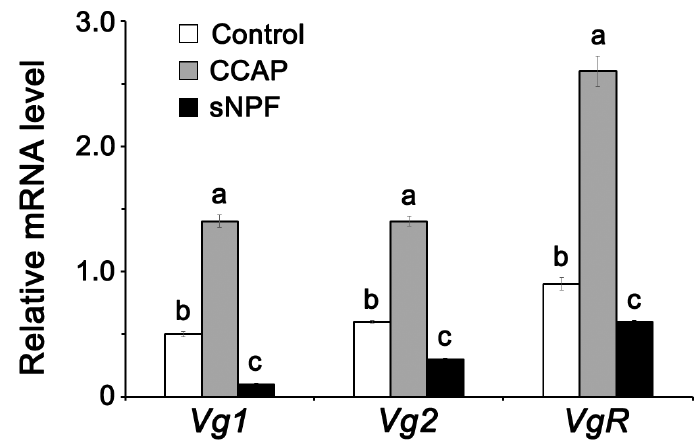
Figure 5. Vg1 , Vg2, and VgR expression in the fat body of normally fed adult females of P. americana 4 days post-injection with CCAP and sNPF. Data are presented as mean ± SEM. Means followed by different letters are significantly different ( p < 0.05), using Duncan’s multiple range test.